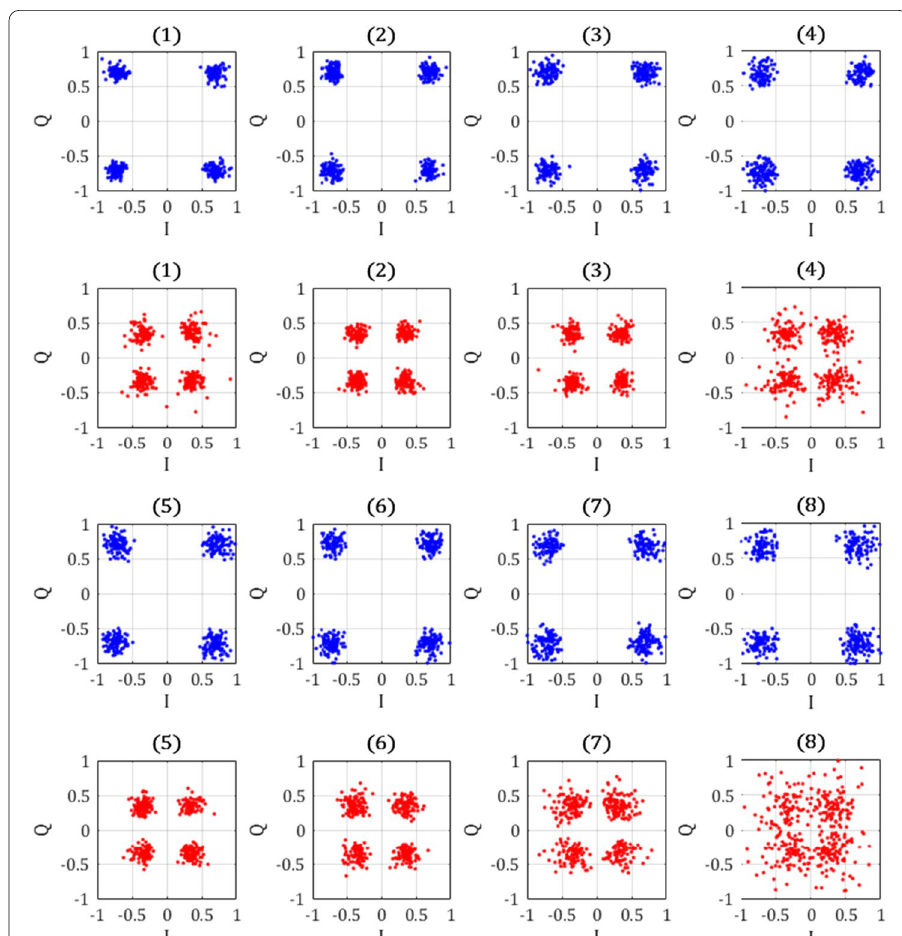
Fig. 7 Constellation diagrams of the received QPSK signal per OFDM group. Row 1 and 3: optical B2B; row 2 and 4: after wireless